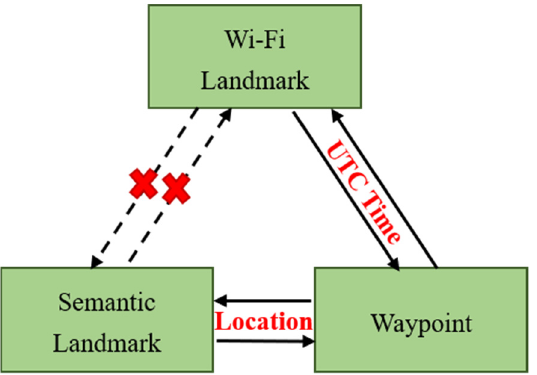
Figure 2. The association relationship among the waypoints, semantic landmarks, and Wi-Fi land- Figure marks.